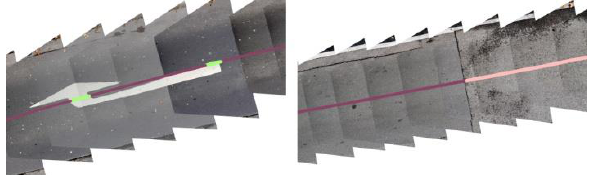
Figure 4. Sample of geo-referenced spectrometer spots, colourized with the class association (Polytec